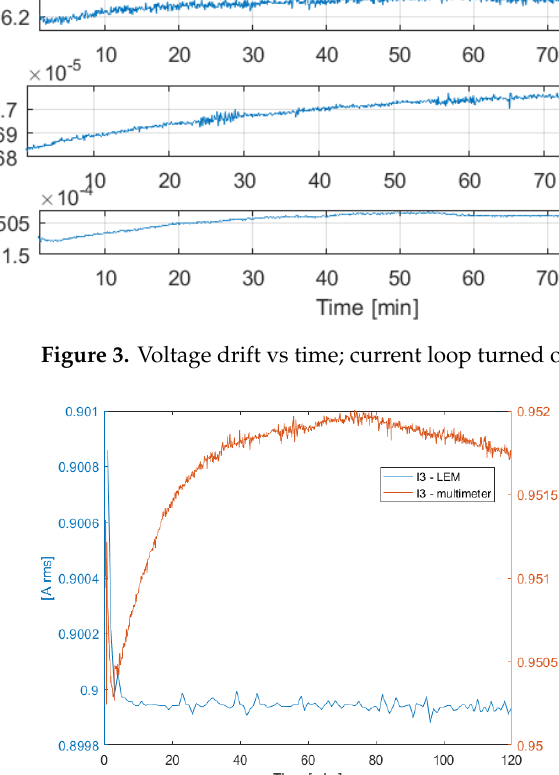
Figure 3. Voltage drift vs time; current loop turned on.